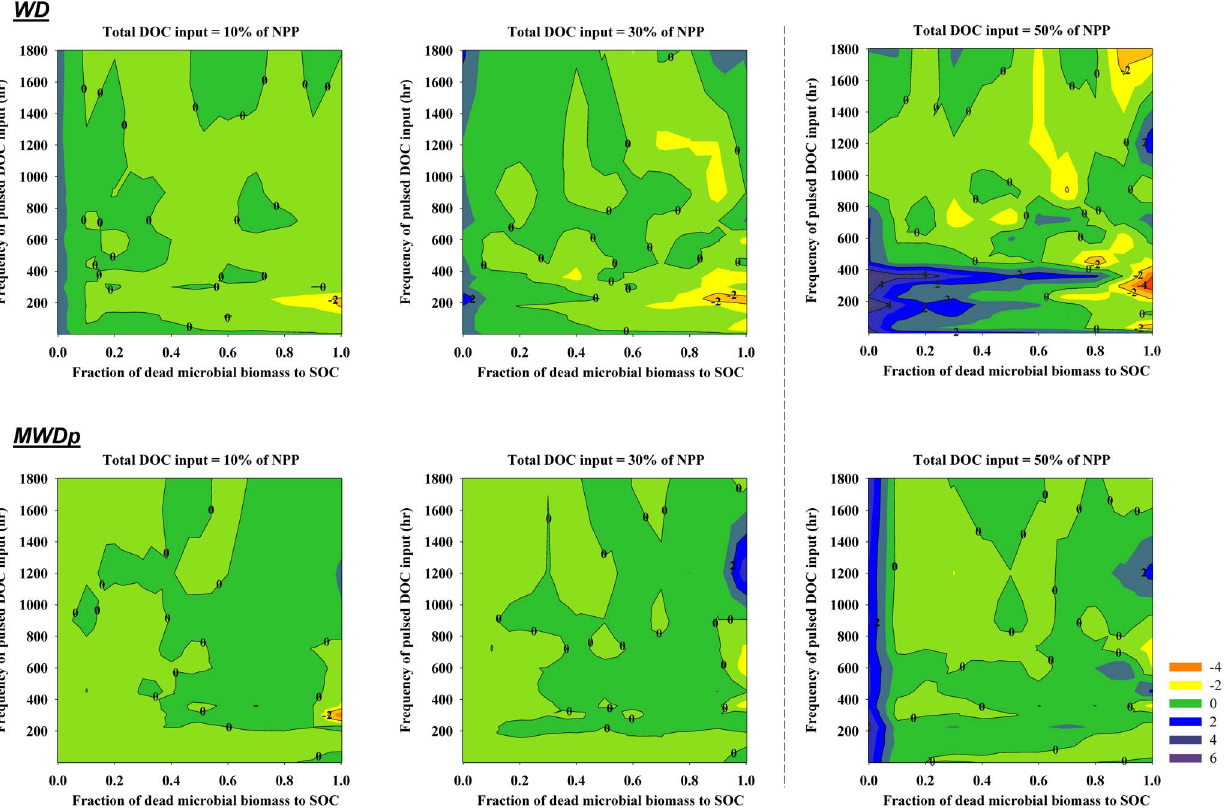
Figure 4. Variations in simulated impacts of water transport on priming effects (g OC m 2 2 yr 2 1 ) associated with different amounts of total DOC input at each site (WD and MWDp) as affected by different frequencies and intensities of DOC input (Y axis) and the quality of microbial necromass (as represented by the fraction of microbial necromass apportioned to SOC). The simulated impacts are indicated as the differences between the simulations with water transport and simulations without water transport.